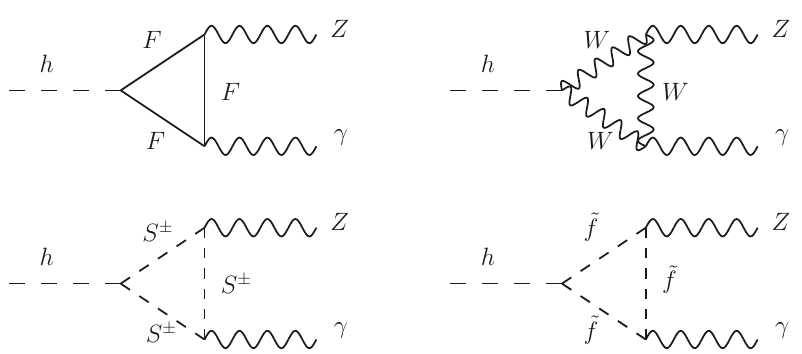
Z(cid:13) in the (cid:22)(cid:23) SSM, where F !